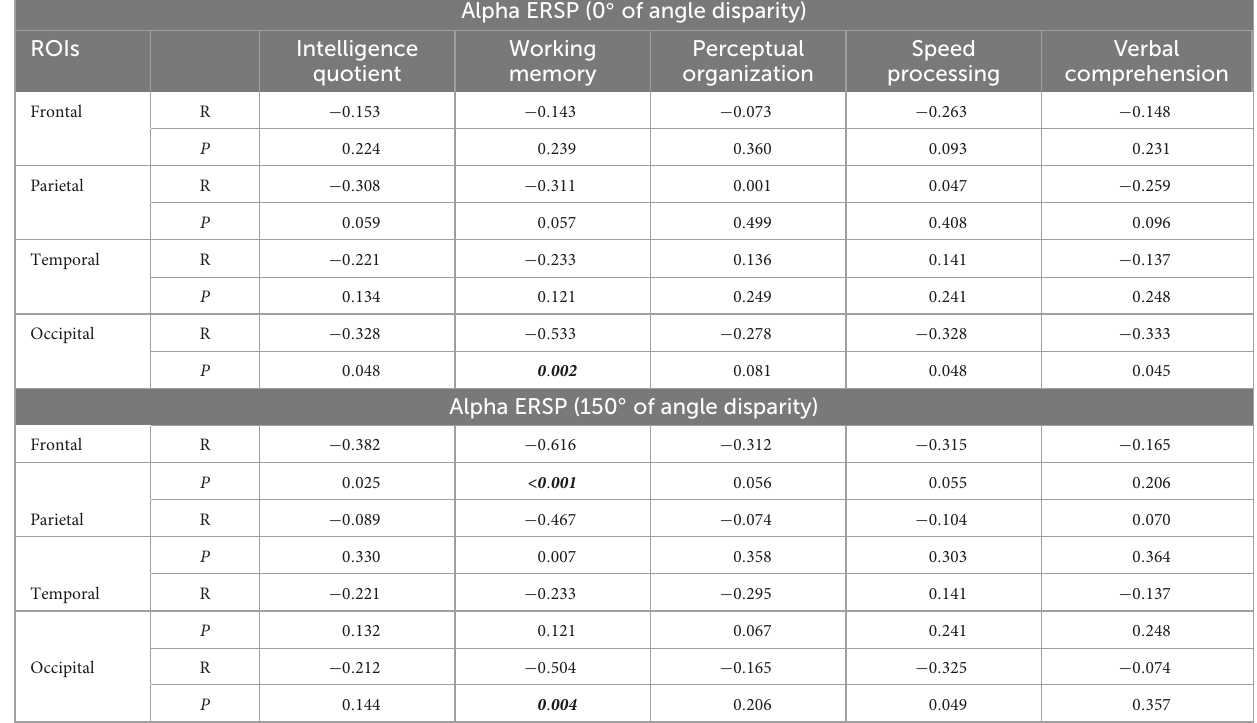
TABLE 1 Correlation coefficients between alpha event-related spectral perturbation (ERSP) values and intelligence